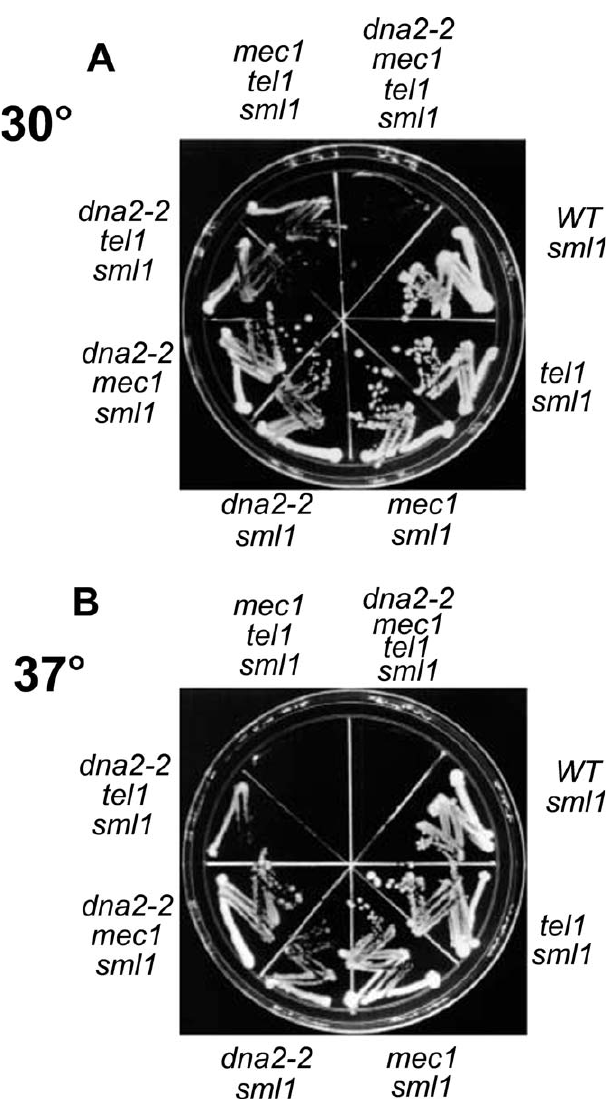
Figure 7. Synthetic Lethality of mec1 D tel1 D with dna2–2 Mutations Strains used in these experiments are listed in Table S4, and were isogenic or congenic with W303 RAD5 þ . Segregants of a MEC1/mec1 D TEL1/tel1 D DNA2/dna2–2 SML1/sml1 D diploid were placed on a YPD plate incubated at 30 8 C (A) or 37 8 C